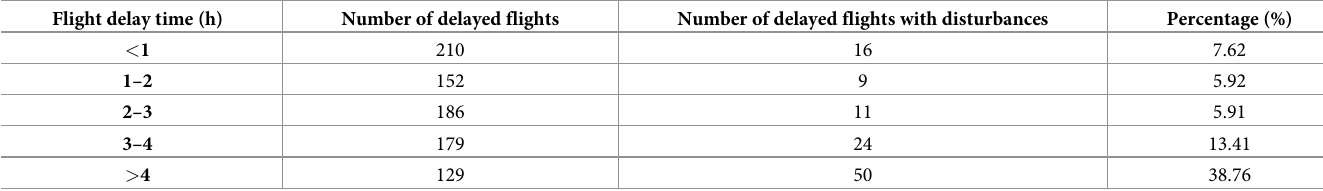
Table 1. Statistics on the length of flight delays and disruptive behaviors at Shenzhen Airport, 2018. Flight delay time (h) Number of delayed